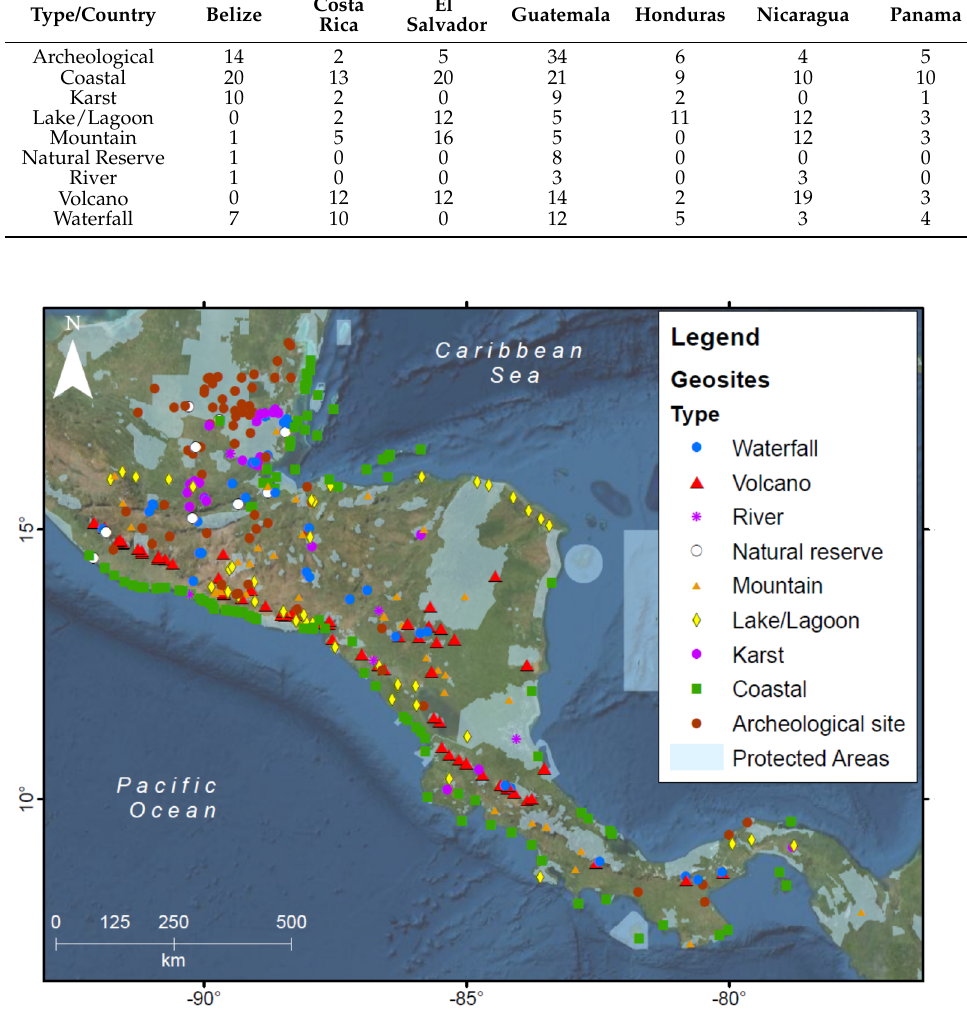
Figure 7. Protected areas in Central America and relevant geosites in Central America based on maps, national reports, or websites about tourism in the region and every country. Table 1. Number of the most popular geosites type in Central America by country based on webpages, touristic maps, and internet-based research.